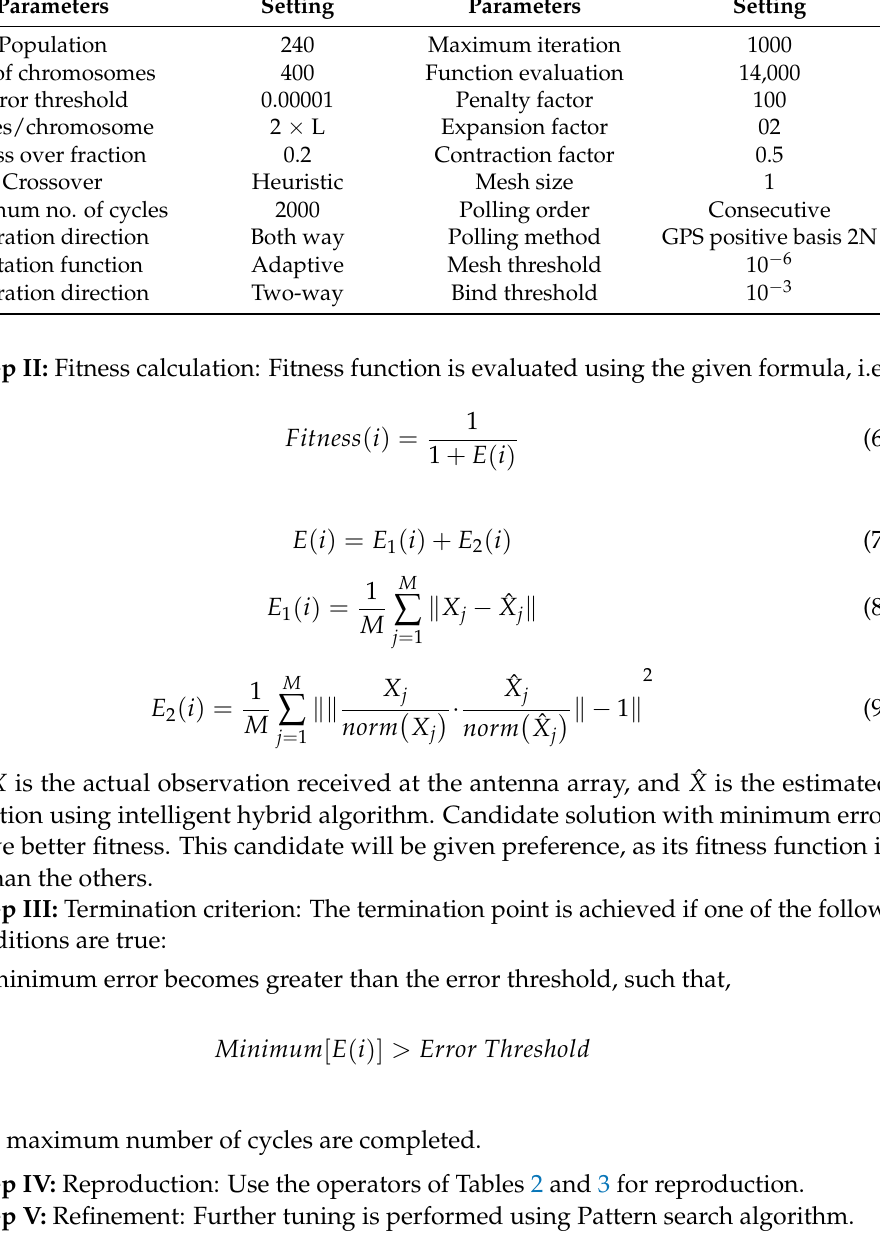
Table 3. Parameters utilized for genetic algorithm and pattern search. Genetic